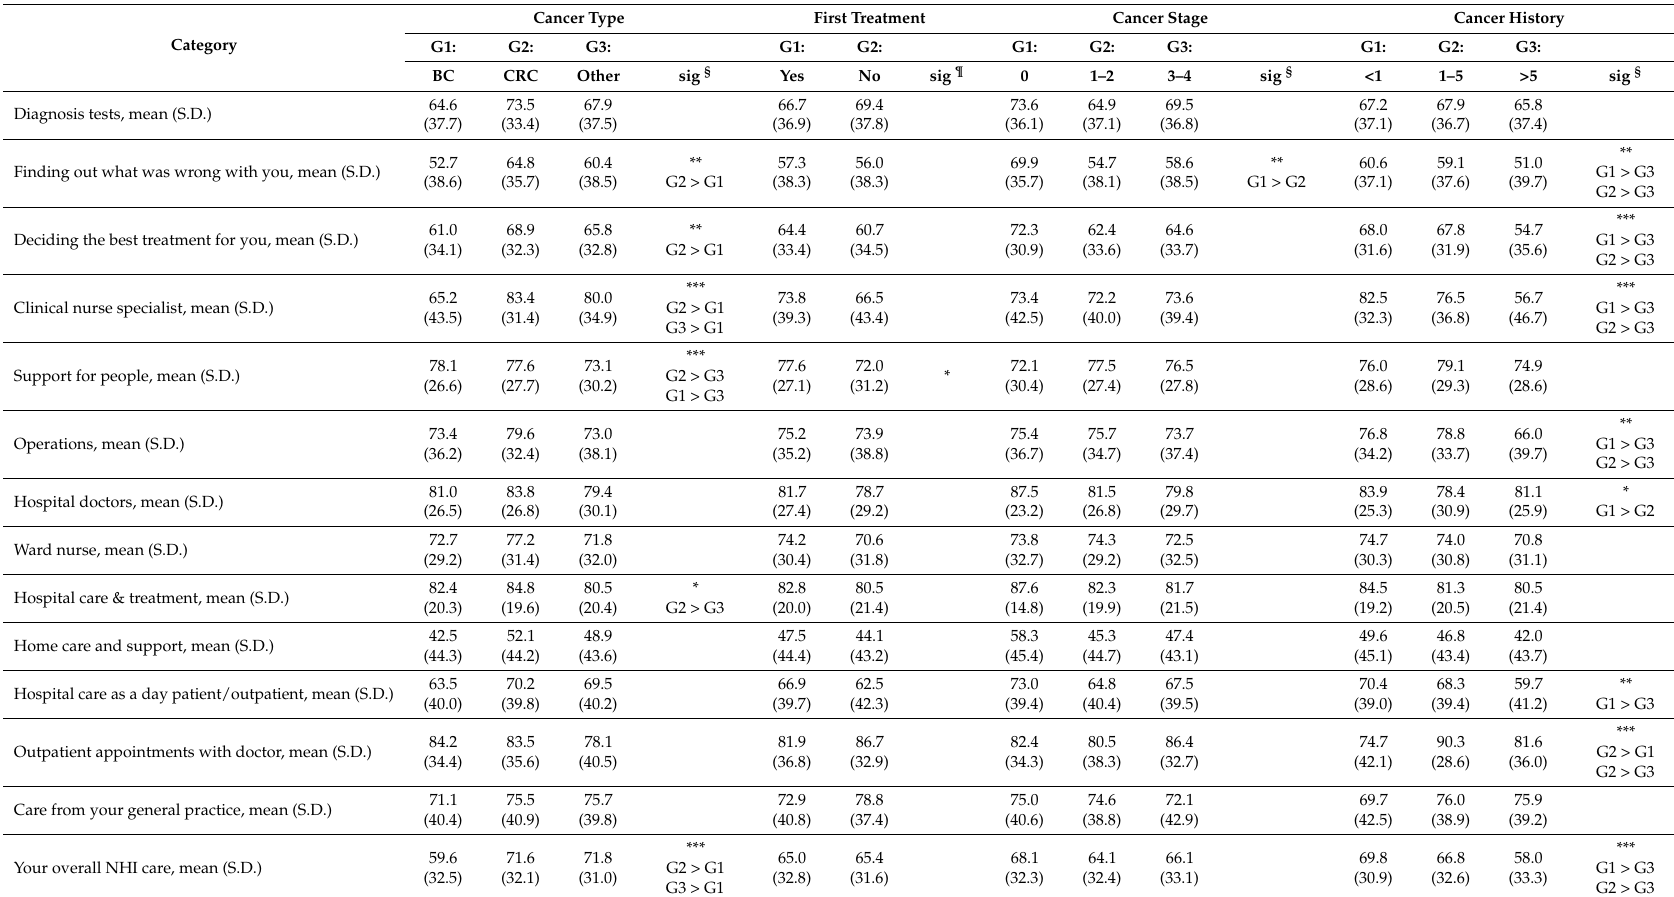
Table 5. Experience of cancer care: categories vs. cancer-specific